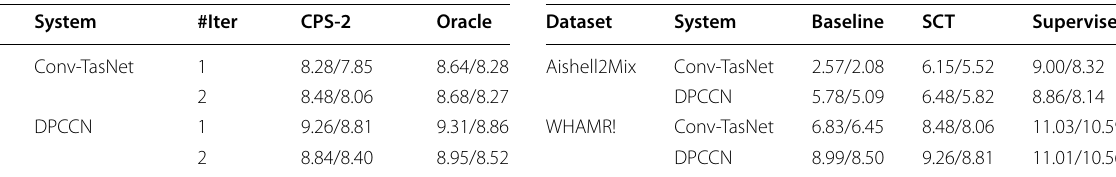
Table 6 SDRi/SI-SNRi(dB) performance on WHAMR! test set with SCT-2